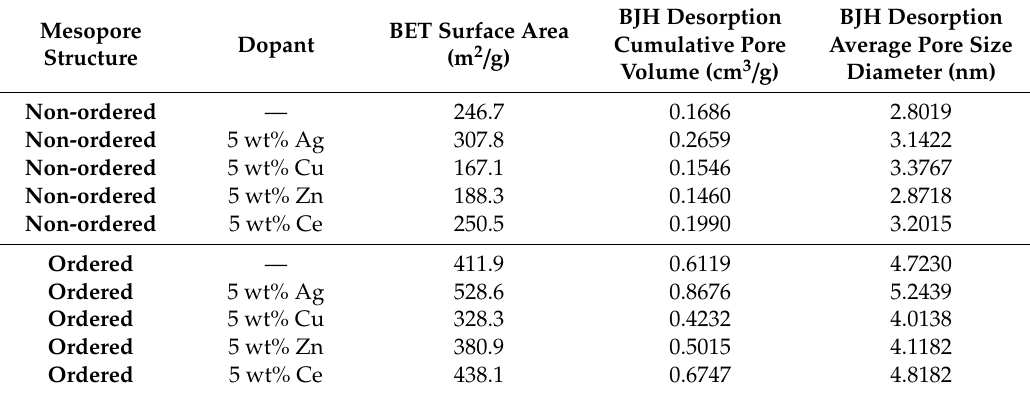
Table 2. Pore properties of MSGs. (BET: Brunauer-Emmett-Teller; BJH: